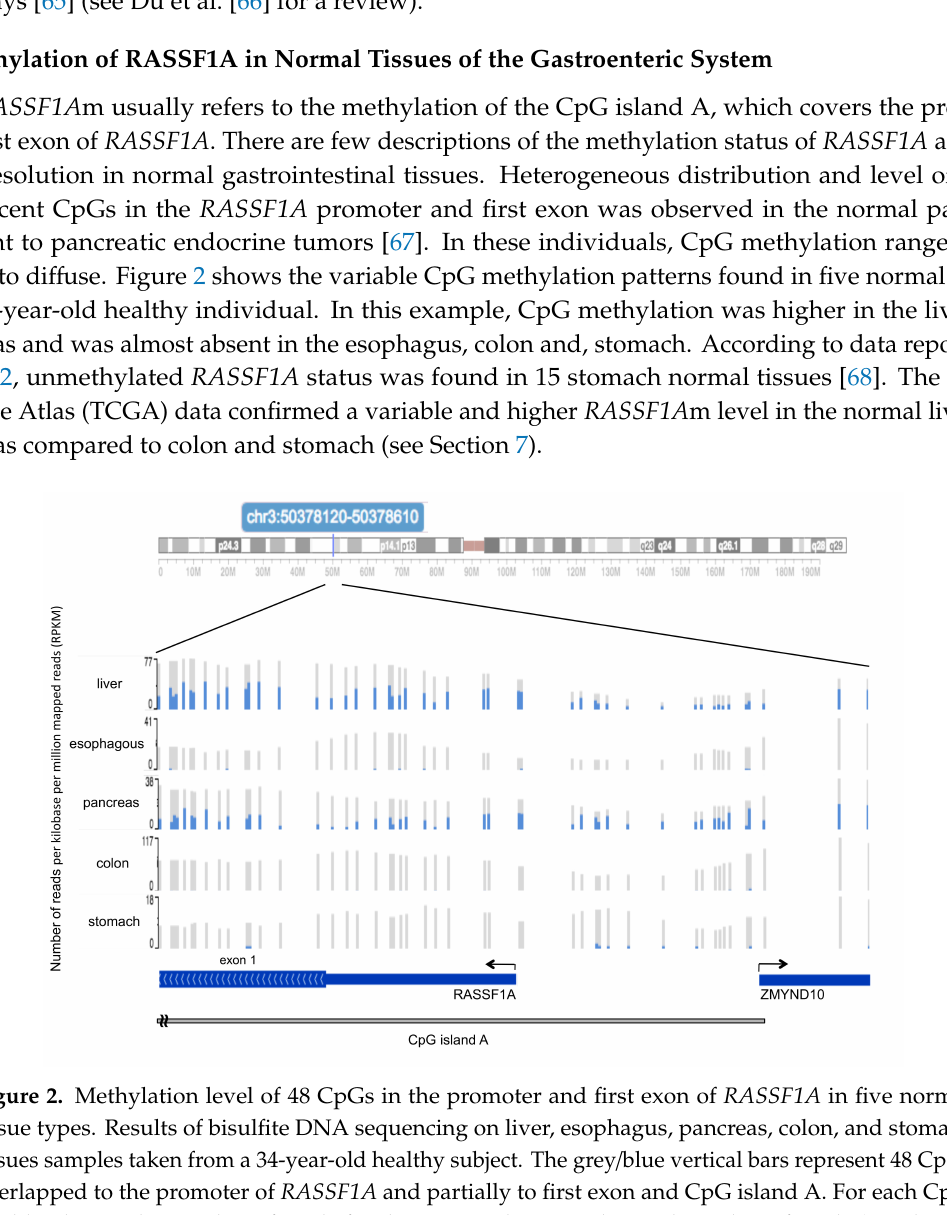
Browser at www.epigenomegateway.wustl.edu, provided by the Roadmap EpiGenome Project